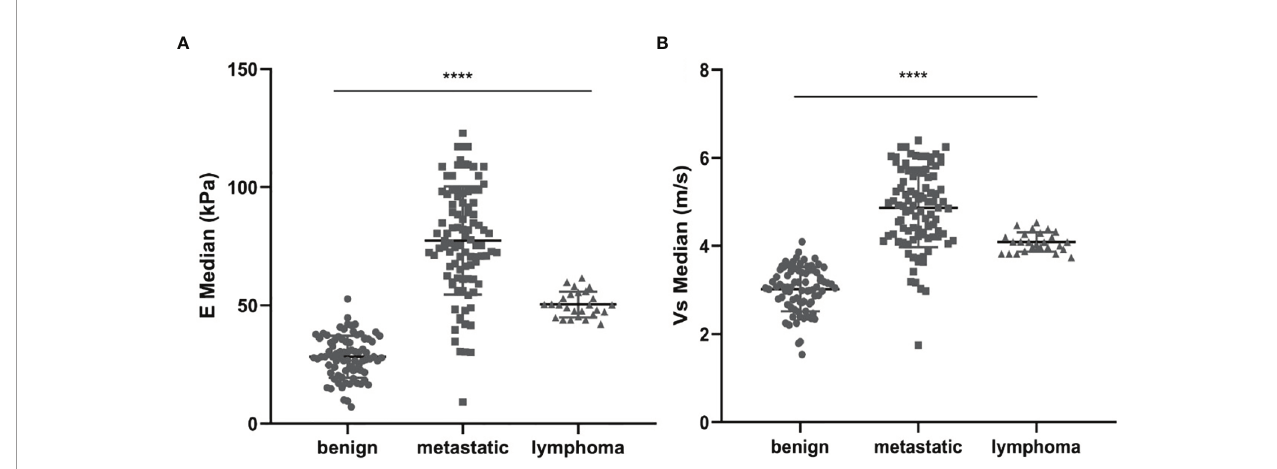
FIGURE 2 | Comparison between E Median values (A) and Vs Median values (B) of both benign LNs, metastatic LNs, and lymphoma, ****represents p < 0.001.